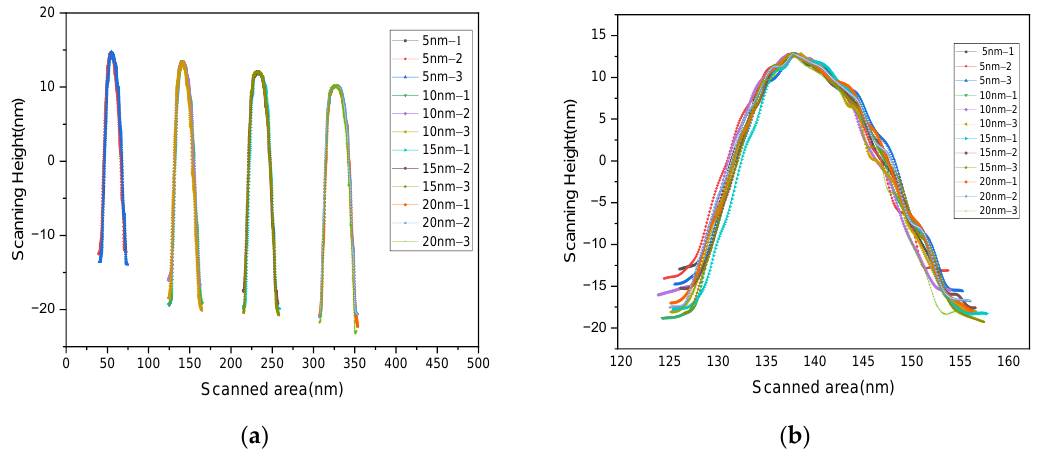
Figure 9. ( a ) Randomly selected measured profiles of the 5 nm, 10 nm, 15 nm and 20 nm linewidth tip characterizer along Y direction; ( b ) AFM probe tip structure obtained along Y direction by the tip characterizer.